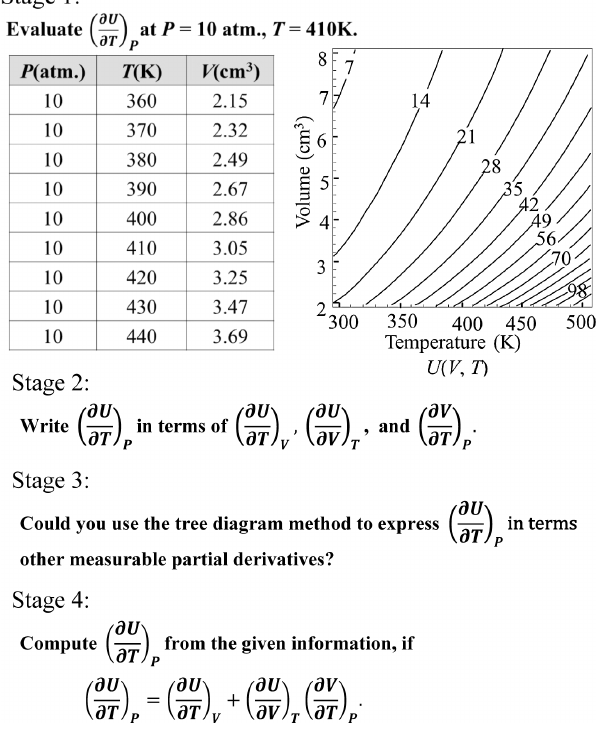
FIG. 3. The problem asked in the interviews. In stage 1, students were given a page with the figure (as shown) and the prompt was also explained verbally. In stages 2 – 4, more explicit prompts were given as